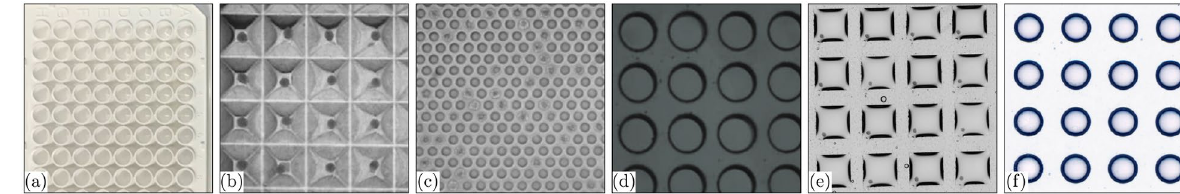
Figure 1. Grid Types. Crops of the grid types ( a ) Microplate 1 , ( b ) Microwell-mesh 2 , ( c ) Agarose Microwells 3 , ( d ) Microwell Array Chips 4 , and ( e – f ) DMA 5 are shown.